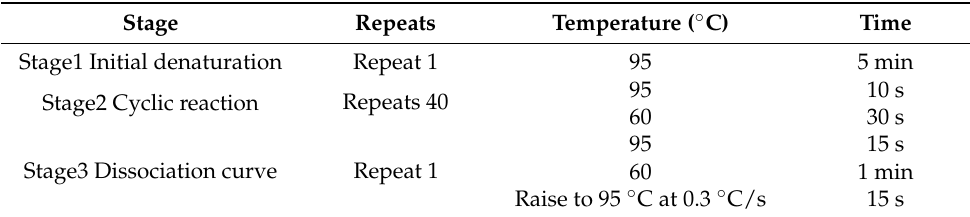
Table 1. Step OnePlus Realtime PCR